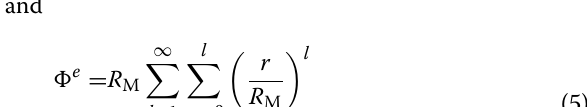
Table 1 Established current system at Mercury in comparison with the Earth’s magnetosphere Earth Mercury Dense